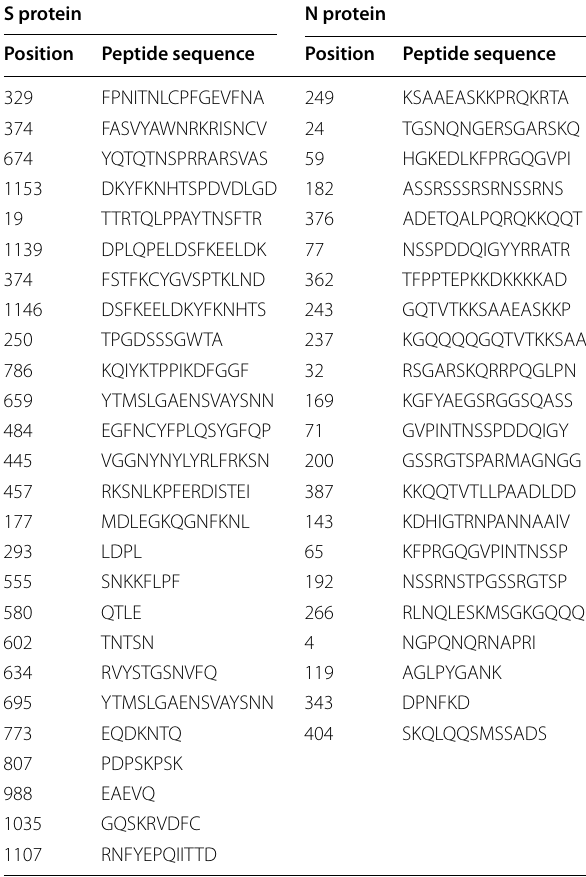
Table 1 Overlap results of predicted linear B cell epitopes of IEDB and ABCPred servers of S and N